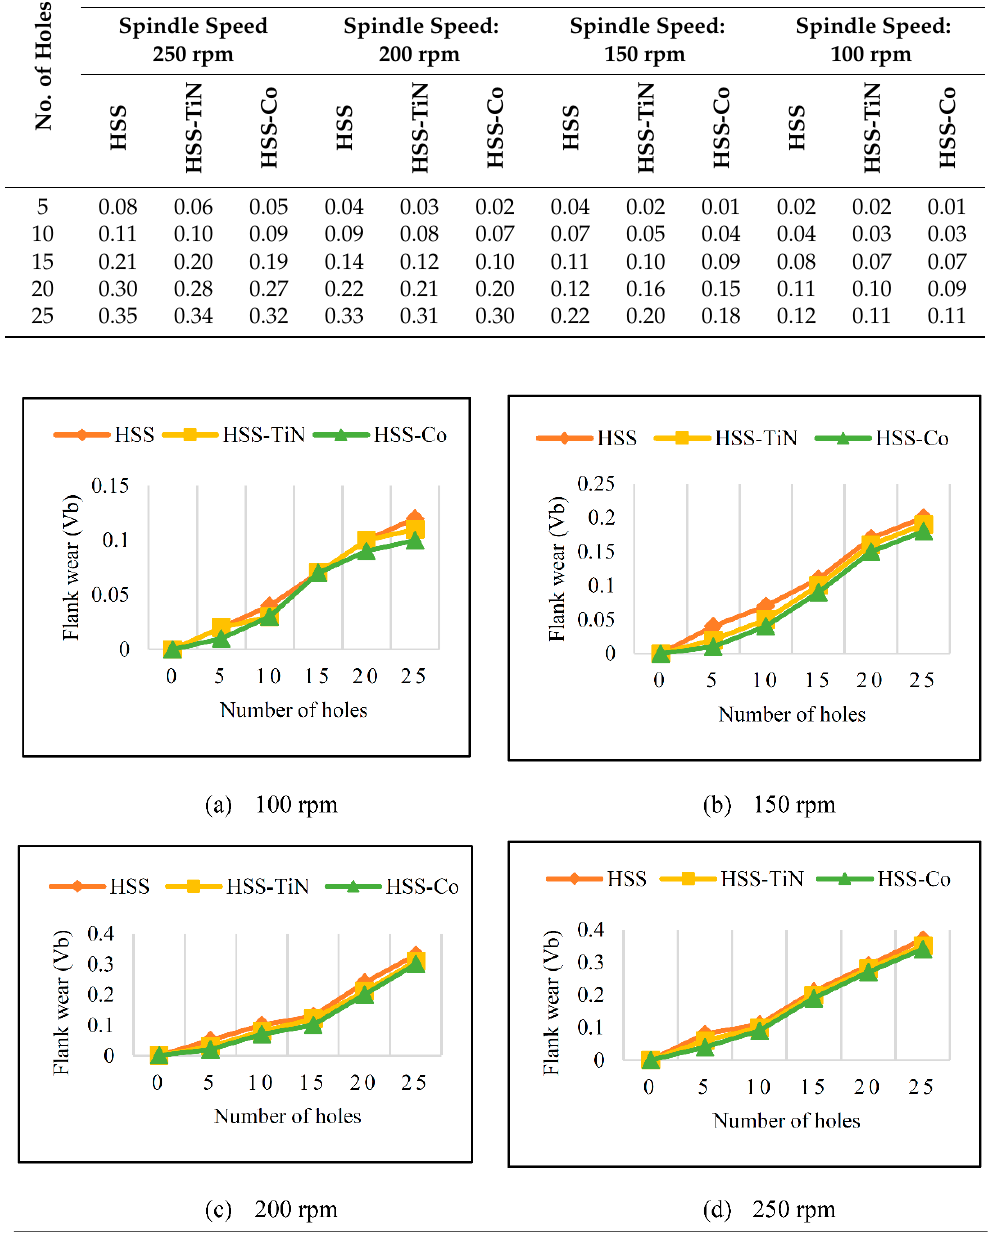
Figure 5. Growth of flank wear of HSS, HSS-TiN, and HSS-Co from ( a – d ).